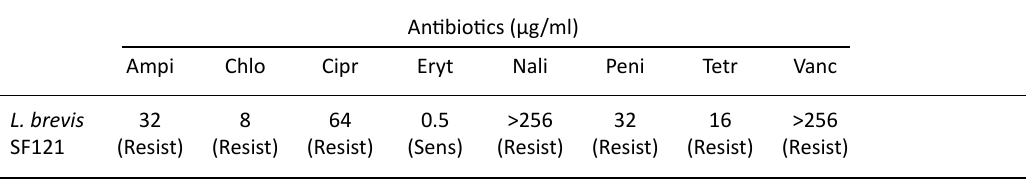
Fig. 1. The L. brevis SF121 on GDCA-MRS medium. The activity of bile salt hydrolase showed with halozone surrounding Table 1. Antibiotic susceptibility profiles of L. brevis SF121 isolate